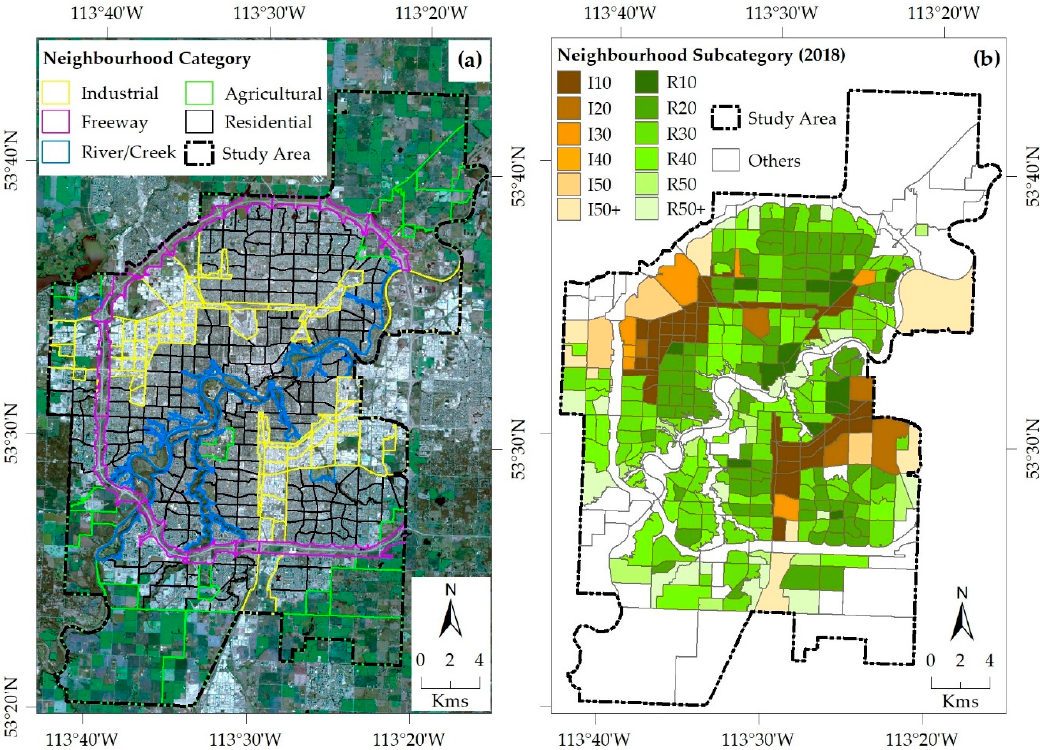
Figure 4. ( a ) Map showing the neighbourhoods grouped into five different categories, overlaid on the Landsat-8 OLI image (2018) with a natural colour composite (RGB:432); and ( b ) map showing the 12 subcategories of the neighbourhoods (2018), where ‘I’ represents the industrial and ‘R’ represents the residential categories.